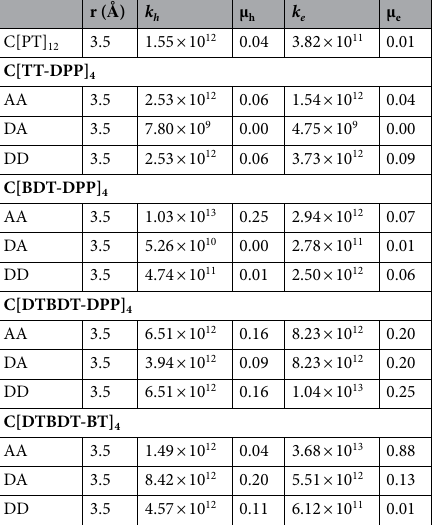
Table 6. Calculated hole and electron charge transport rate constant k h /k e (S −1 ), hole and electron mobility μ h /μ e (cm 2 V −1 S −1 ) using coupling values obtained from three different packing configurations of macrocyclic compounds with charge transport distance r ( Å ) between two macrocycles, obtained with Eq. (6) and